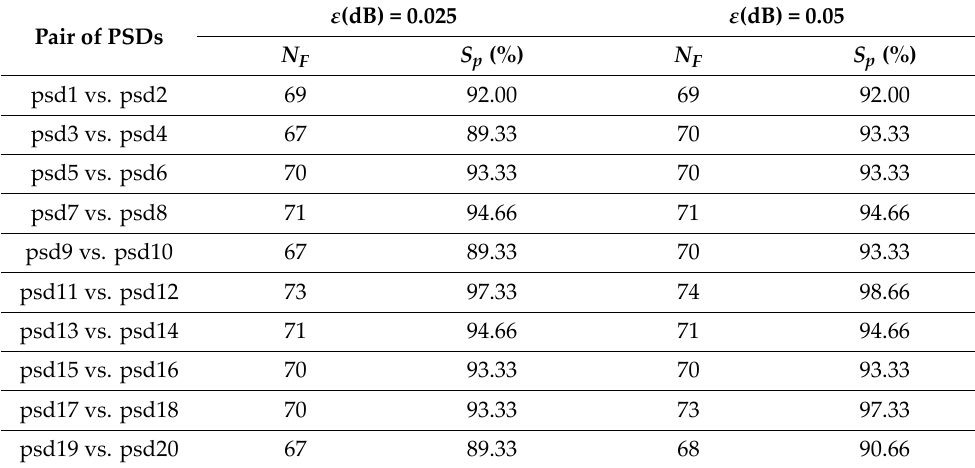
Table 3. Results of the comparison of the 20